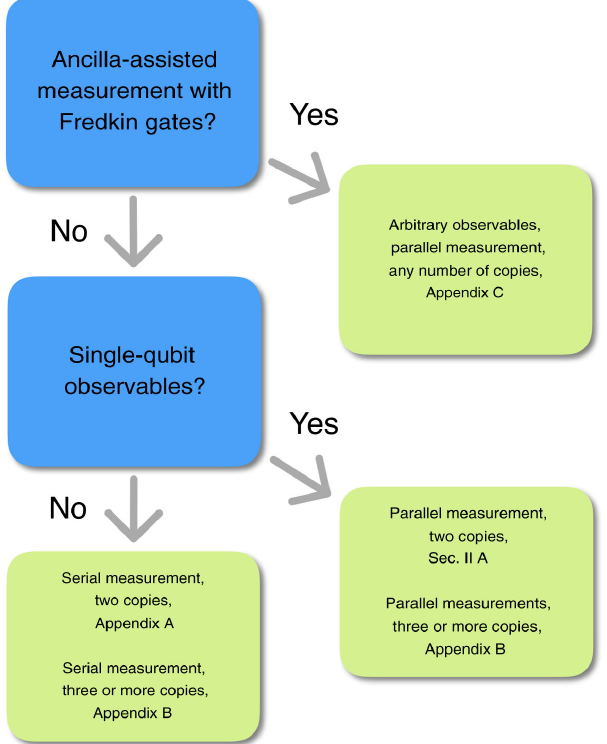
FIG. 2. A flowchart that describes the choices involved in selecting between the different variants of virtual distillation presented in this work. Blue boxes denote questions for the experimentalist to answer about the available quantum resources and problem to be studied; green boxes link to the relevant sections in the text and briefly summarize the main features of each variant. The flowchart provides direction to the most flexible variant given the answers provided in the blue boxes, but the actual experimental performance depends on many factors.